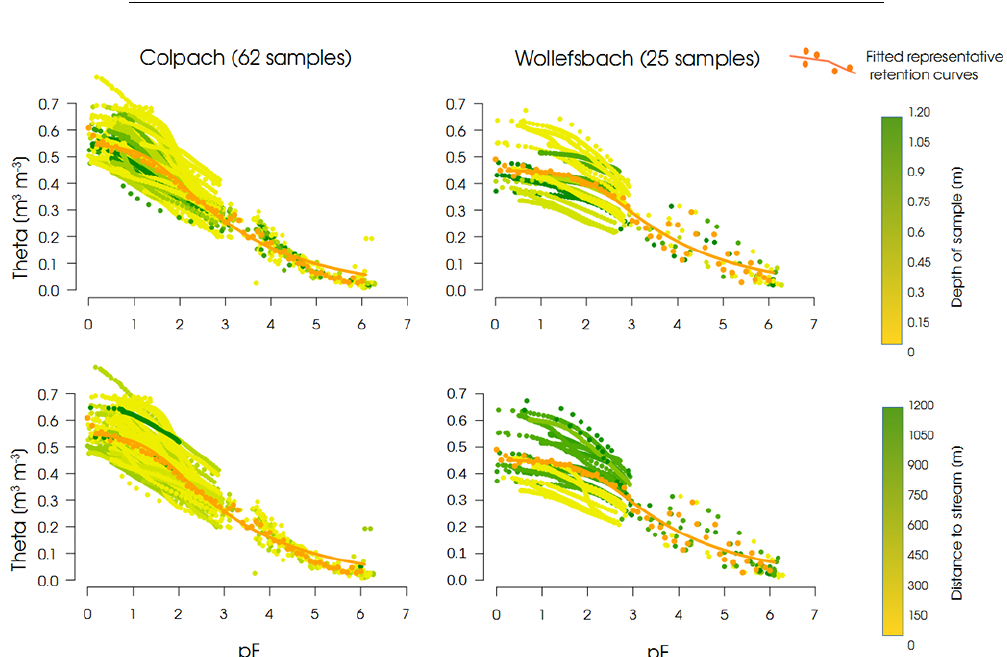
Figure 7. Fitted soil water retention curves and measured soil water retention relationships for the Colpach (a) and Wollefsbach (b) catch-